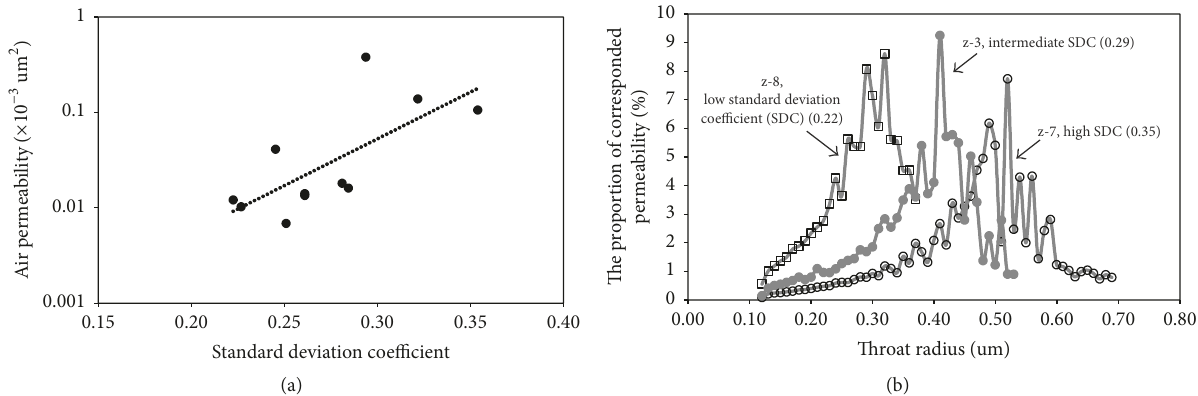
Figure 8: The correlation of throat and permeability of the samples from the Upper Triassic Chang 7 Member, Odors Basin. (a) Correlation of standard variation coefficient of the throat radii and permeability; (b) the curve of throat radii and the permeability value that result from, correspondingly, the three curve presenting high, low, and intermediate standard deviation coefficient, which stand for high, low, and intermediate heterogeneity degree of the throat radii in mathematical distribution.